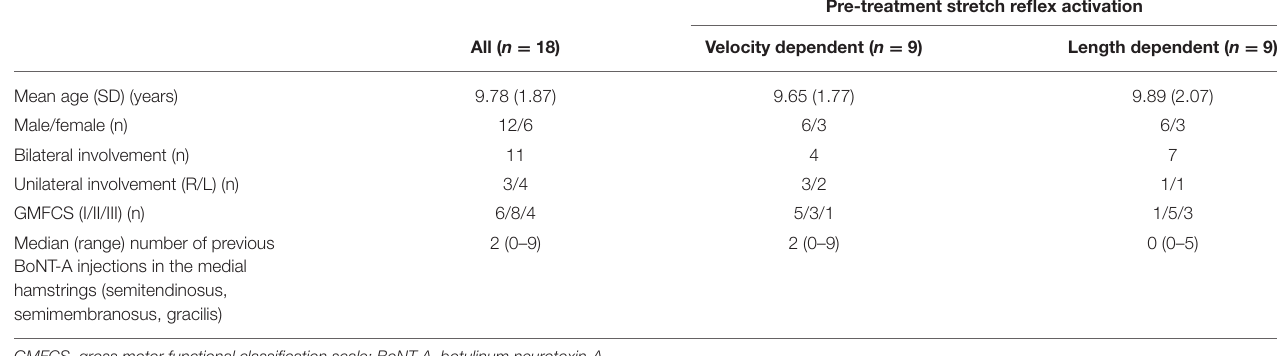
TABLE 1 | Included subject characteristics.